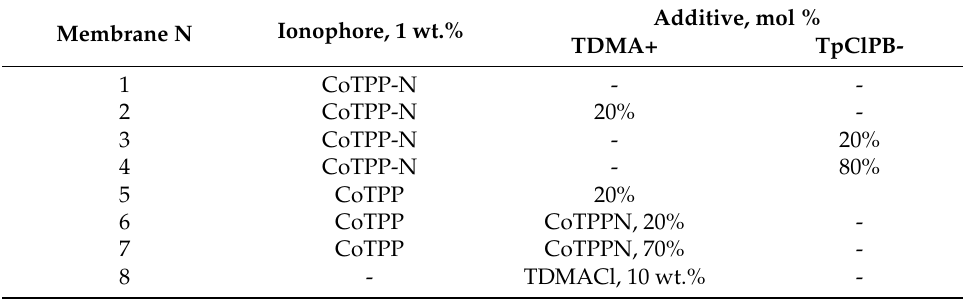
Table 1. The compositions of tested CoTPP-N membranes. Membrane N Ionophore, 1